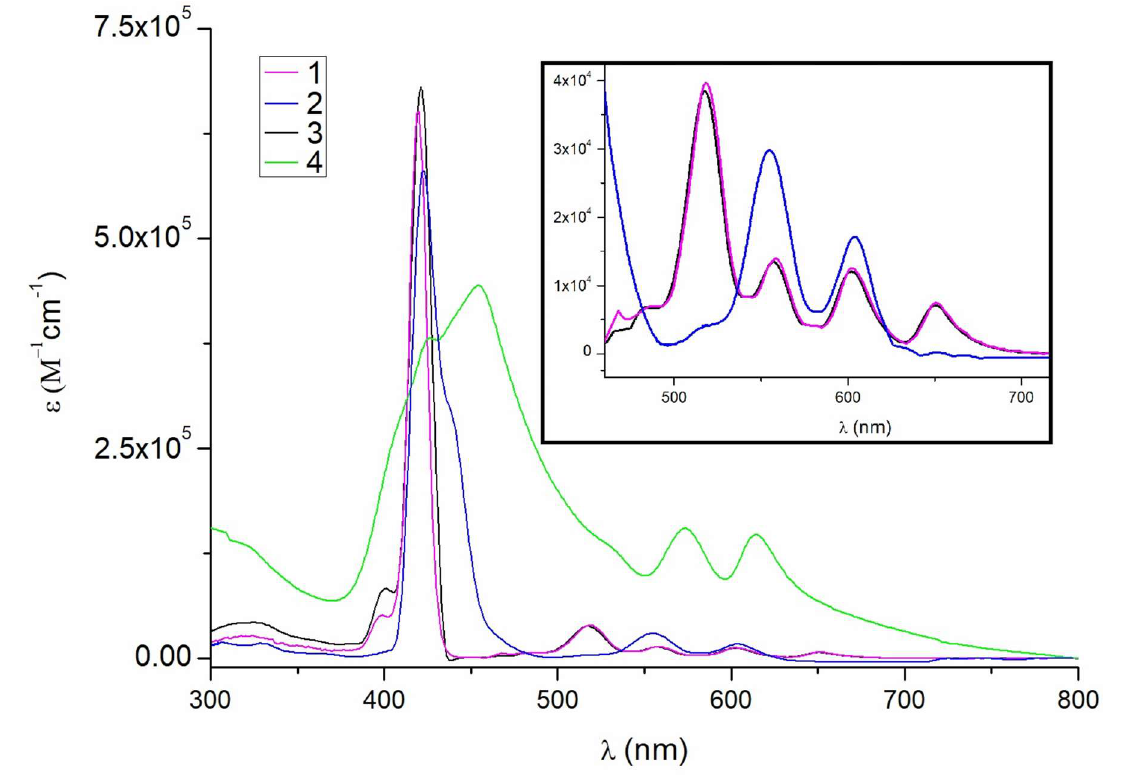
Figure 1. UV-visible spectra of triads 1 – 4 in CHCl 3 (Inset: high resolution of Q band).